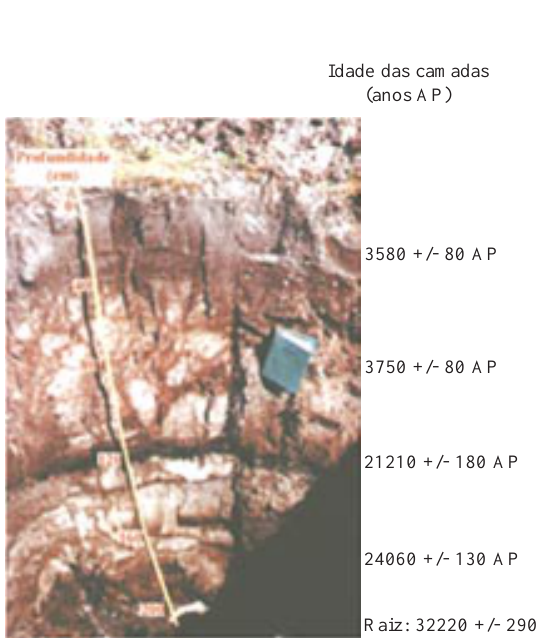
Figura 4. Aspectos morfológicos do Paleossolo -